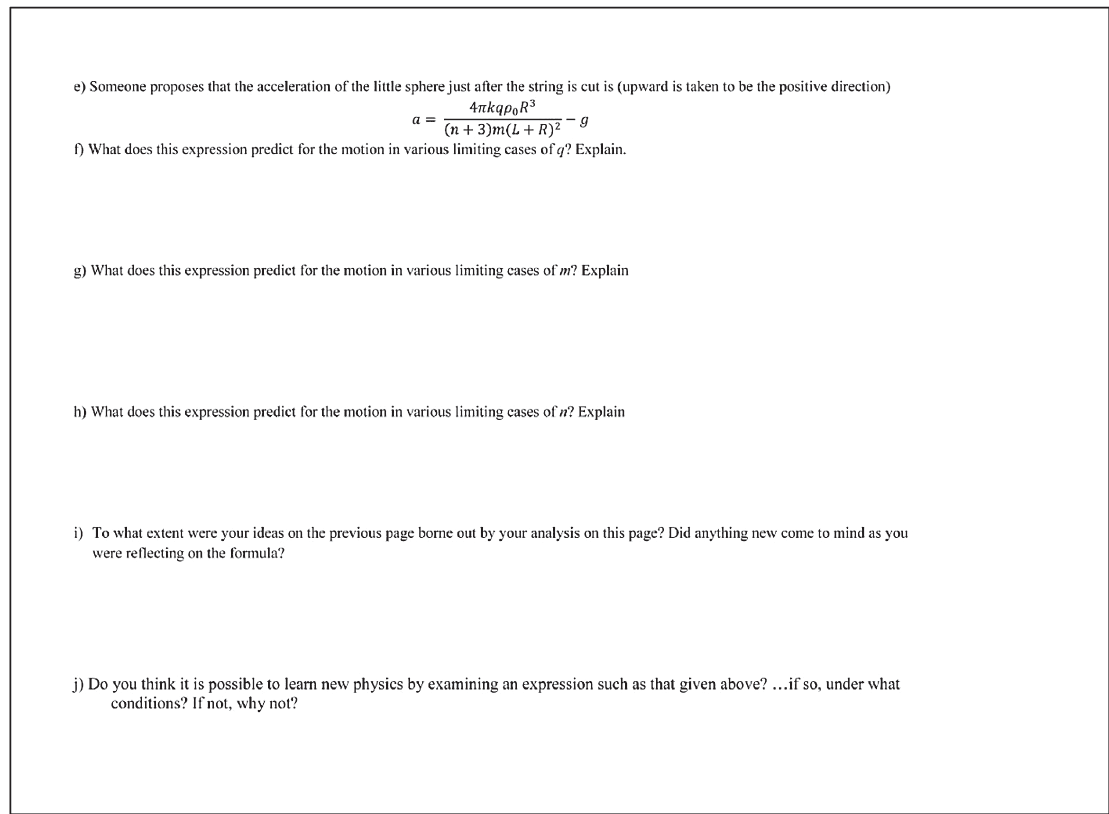
FIG. 17. Sphere with nonuniform charge density referenced in Fig. 10, layer 2 of